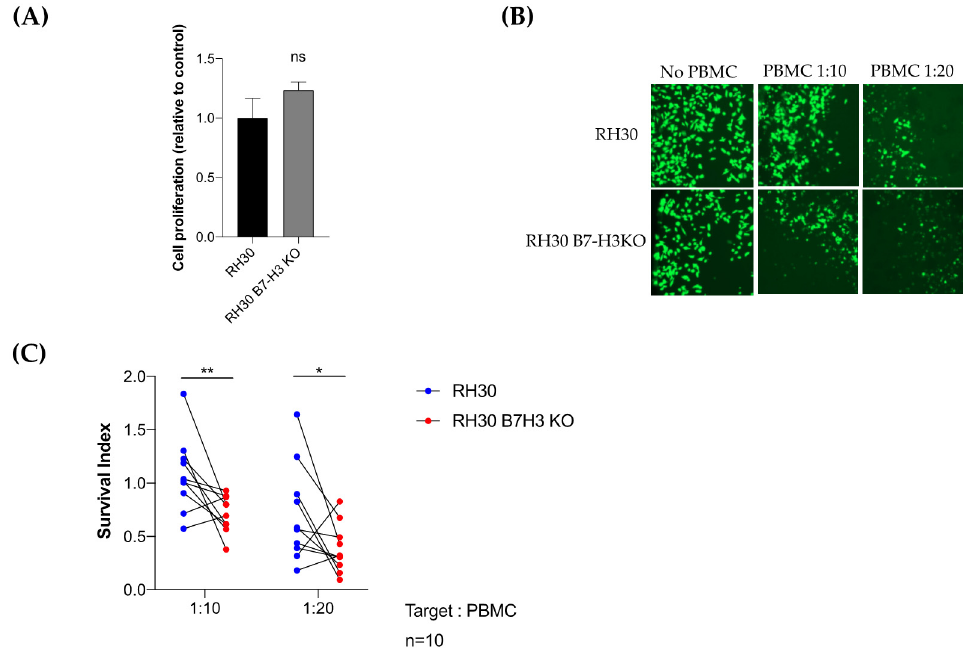
Figure 6. Loss of B7-H3 expression in RMS tumor cells is associated with higher T-cell cytotoxicity. ( A ) Histogram showing relative proliferation of B7-H3 knockout RH30 cells compared to wild-type cells. ( B ) Representative pictures of calcein-labeled wild-type and B7-H3 knockout RH30 cells after co-incubation with activated PBMCs for 4 hours. ( C ) Survival index of wild-type and B7-H3 knockout RH30 cells co-cultured with activated PBMC (N = 10 normal donors) at a ratio target: PBMC of 1:10 or 1:20. (** p < 0.01; * p < 0.05, Paired t -test).